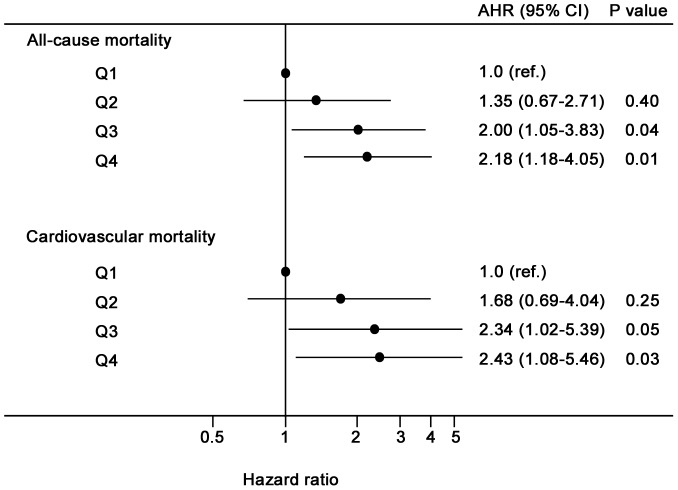
Hazard ratio for all-cause and cardiovascular mortality according to serum potassium variability.Adjustments included age at initiation of PD, gender, BMI, diabetes status, CCI, hemoglobin, serum albumin, hs-CRP, PDV/BSA, and within-patient mean of serum potassium. Q1: (CVSP) <7.5%; Q2: (CVSP) 7.5 to <12.0%; Q3: (CVSP) 12.0 to <16.7%; Q4: (CVSP) ≥16.7%.